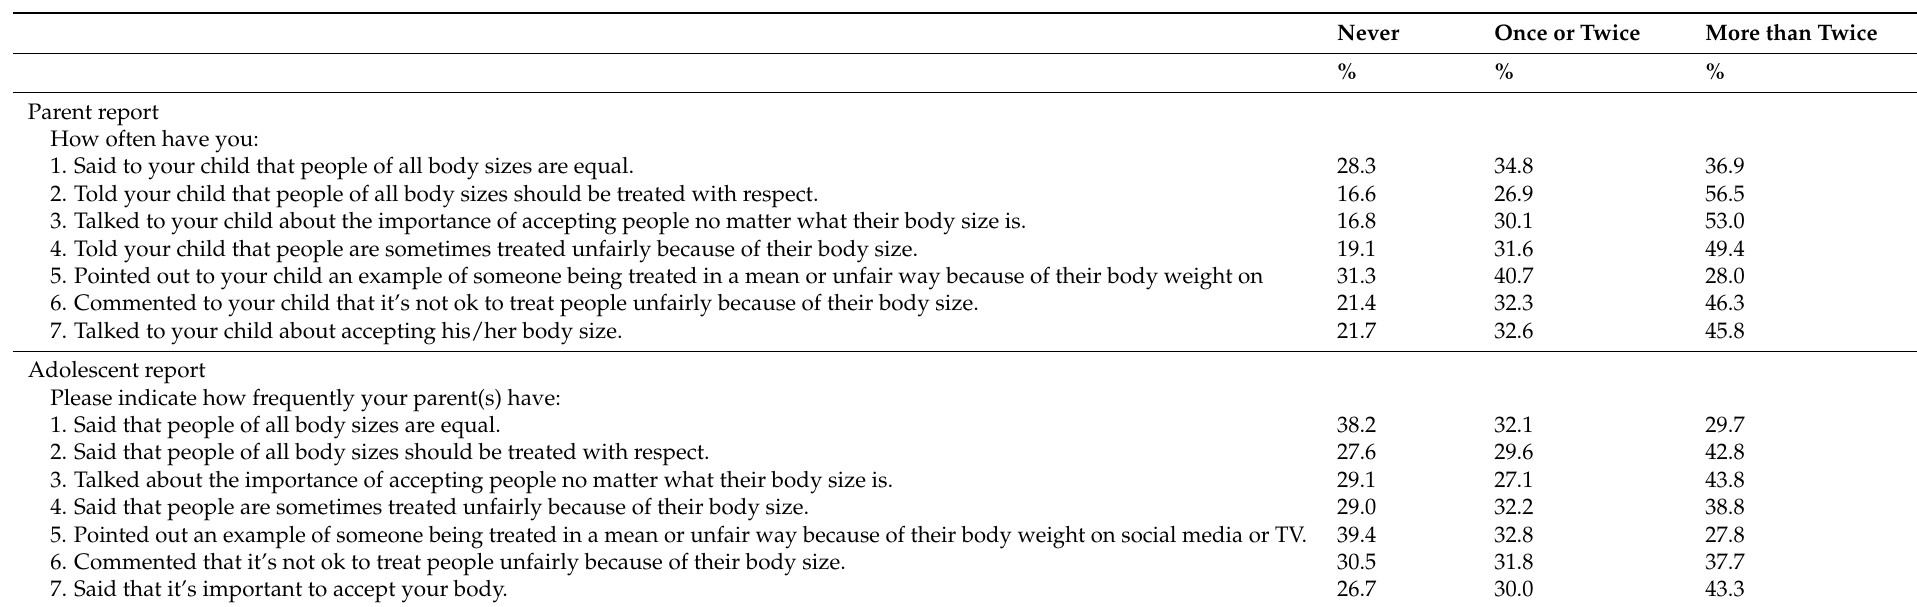
Table 6. Frequency of parental weight